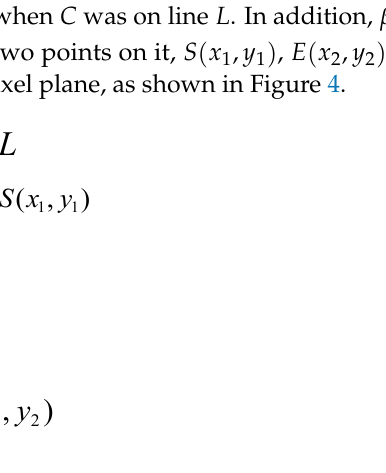
Figure 4. Schematic diagram of the relative position of the line and the point outside the line.